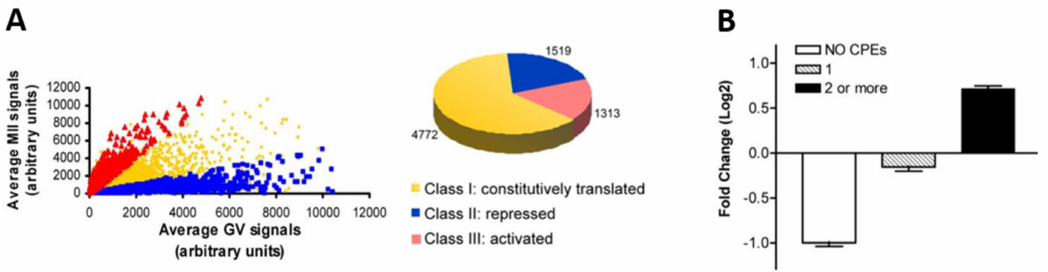
Figure 8. The oocyte translation program. ( A ) Comparison of transcripts associated with the polysome in GV and MII mouse oocytes divided into three classes: Constitutively translated (yellow), repressed (blue) or activated (red) between the two stages according to a two-fold change cut-o ff . ( B ) The relation between the number of CPEs in an analysis of the 3 (cid:48) UTRs of 4645 transcripts and log2-fold change in polysome association between GV and MII. Source: Chen et al., 2011 [34].